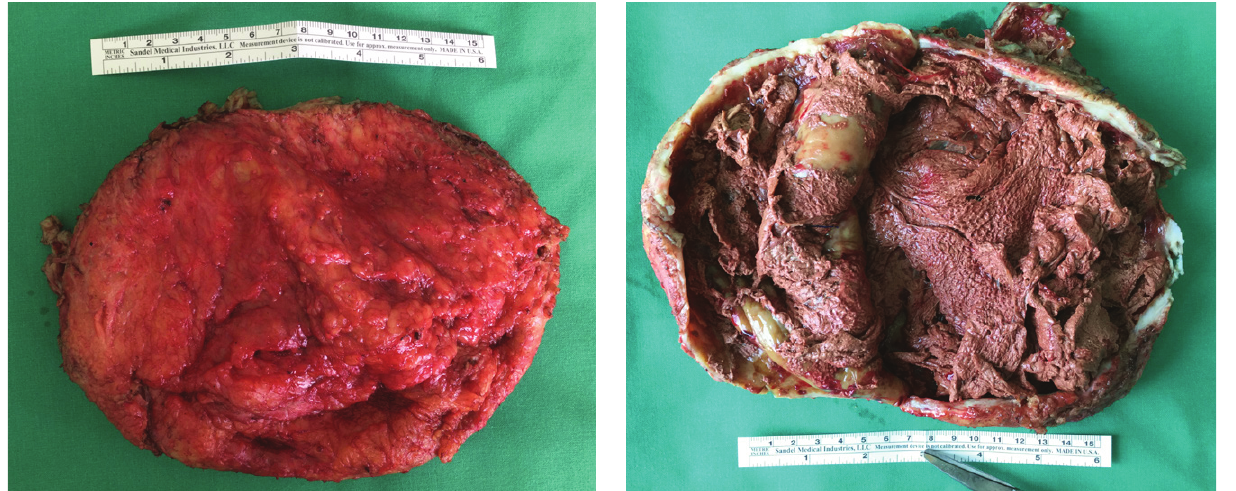
Figure 6: Removed